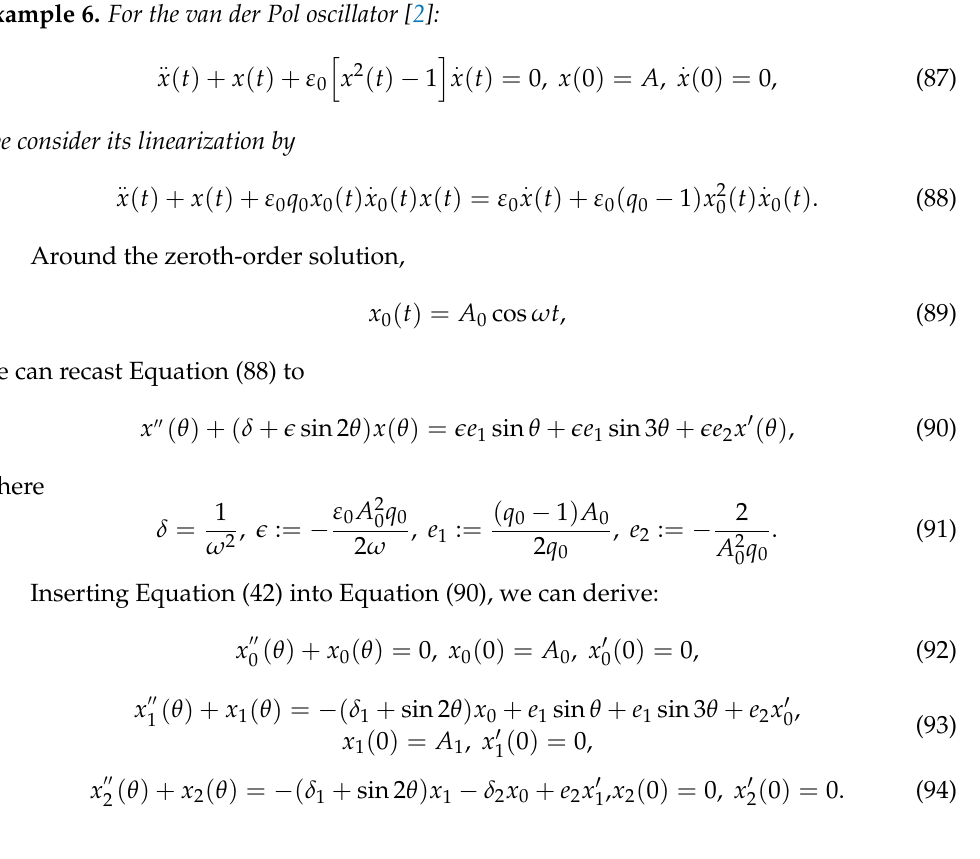
Figure 2. For Example 5, comparing the exact solution obtained by the RK4 and the solution obtained by the present method: ( a ) time histories of displacement within one period and ( b ) periodic orbits in . (cid:0) (cid:1) x , x the phase plane